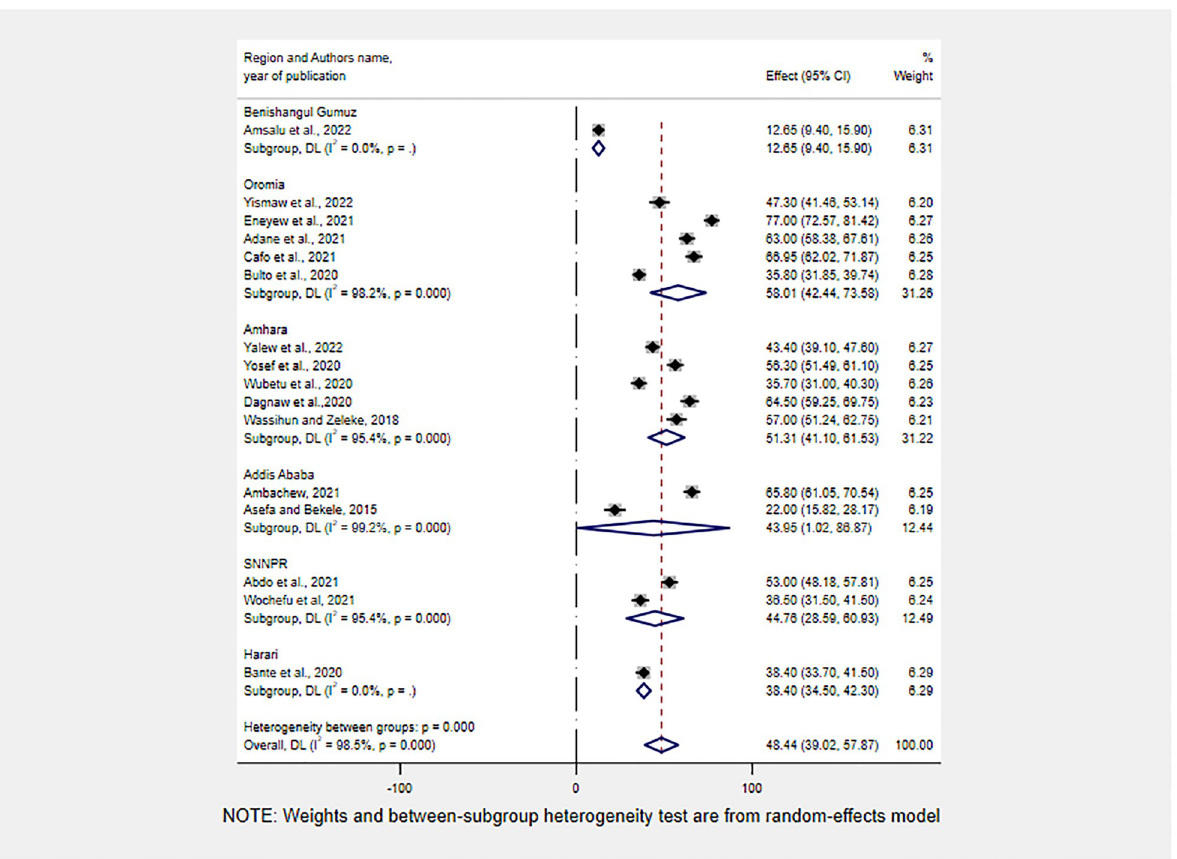
Fig 3. Sub-group analysis for the pooled prevalence of RMC by geographical regions of Ethiopia, 2013–2022.